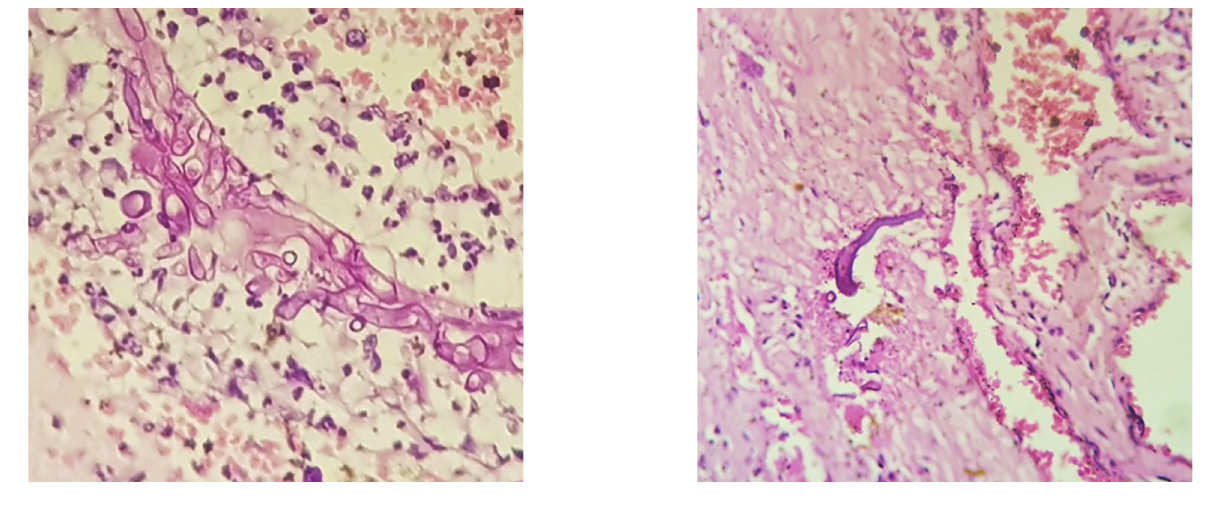
Figure 6a - Photomicrograph of nasal cavity mucosa and eyelid mucosa with mucormycosis lesions. A, Mucormycosis accumulation in the submucosal layer with perivascular